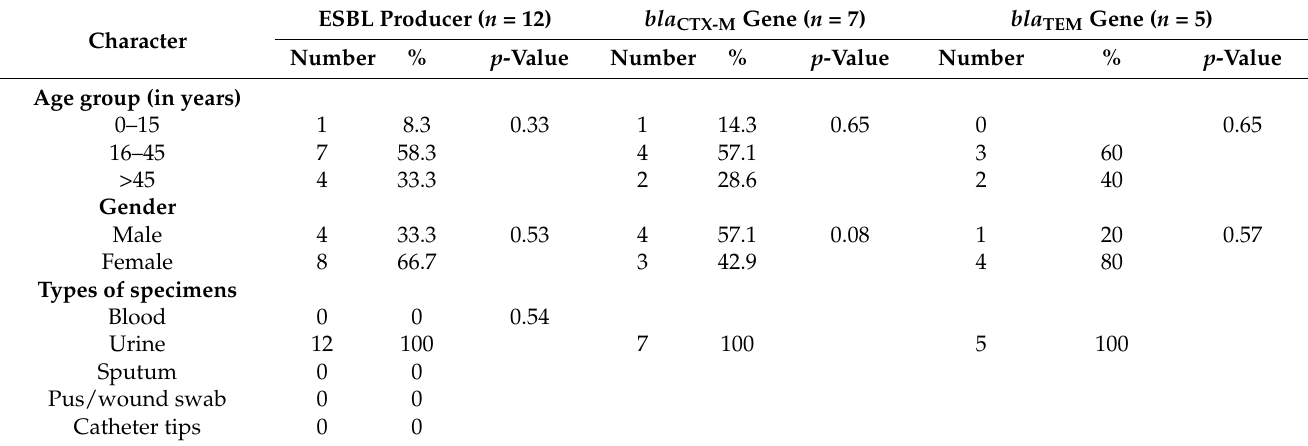
Table 4. Prevalence of ESBL producers, bla CTX-M , and bla TEM genes in E. coli according to age, sex, and types of specimens.